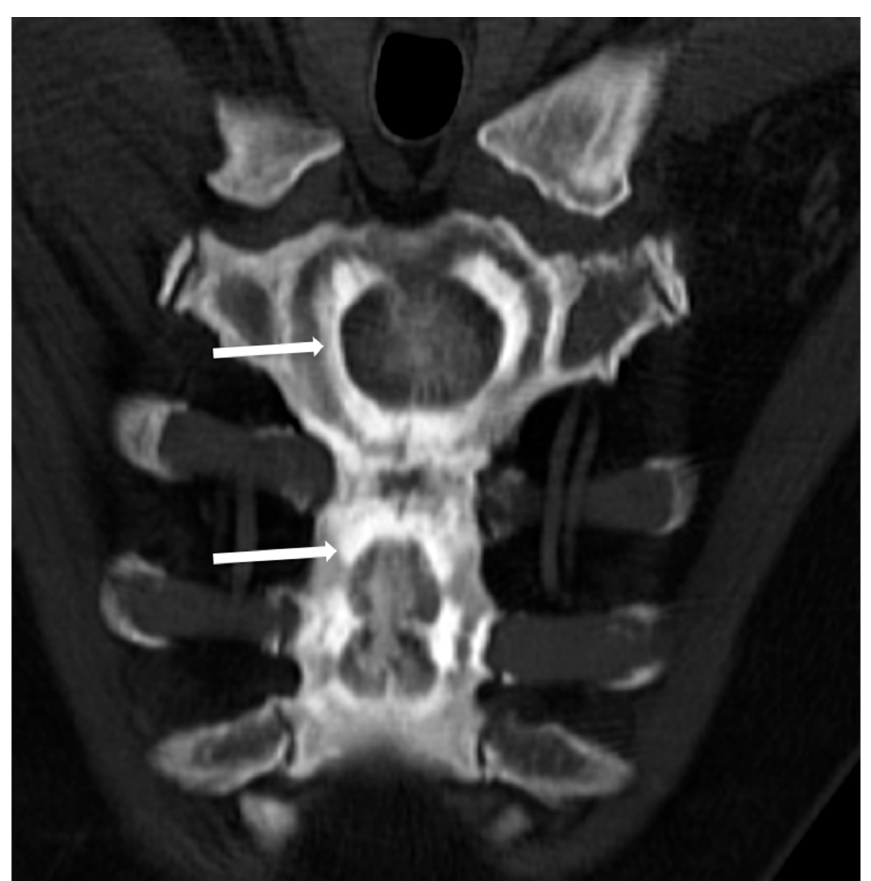
Figure 3. Computed Tomography (CT, coronal-oblique reconstruction) of the sternum in a 48-year-old male affected by osteopetrosis (ADO type 2). The so-called ‘bone in bone’ appearance is detectable with a well-defined increased density within the skeletal segment involved (arrows).